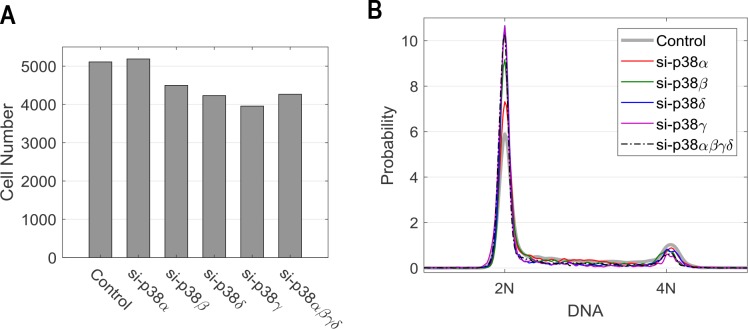
Cells are still cycling upon the knockdown treatments.Cell count (A) and DNA histogram (B) 2 days post siRNA transfection corresponding to each of the knockdown conditions. Cell number was quantified by imaging the central region of the wells (~50% coverage). Combined with knowledge of seeding density, the cell counts shown here imply duplication of cell number per day during the experiments (details see Materials and methods -siRNA transfection).